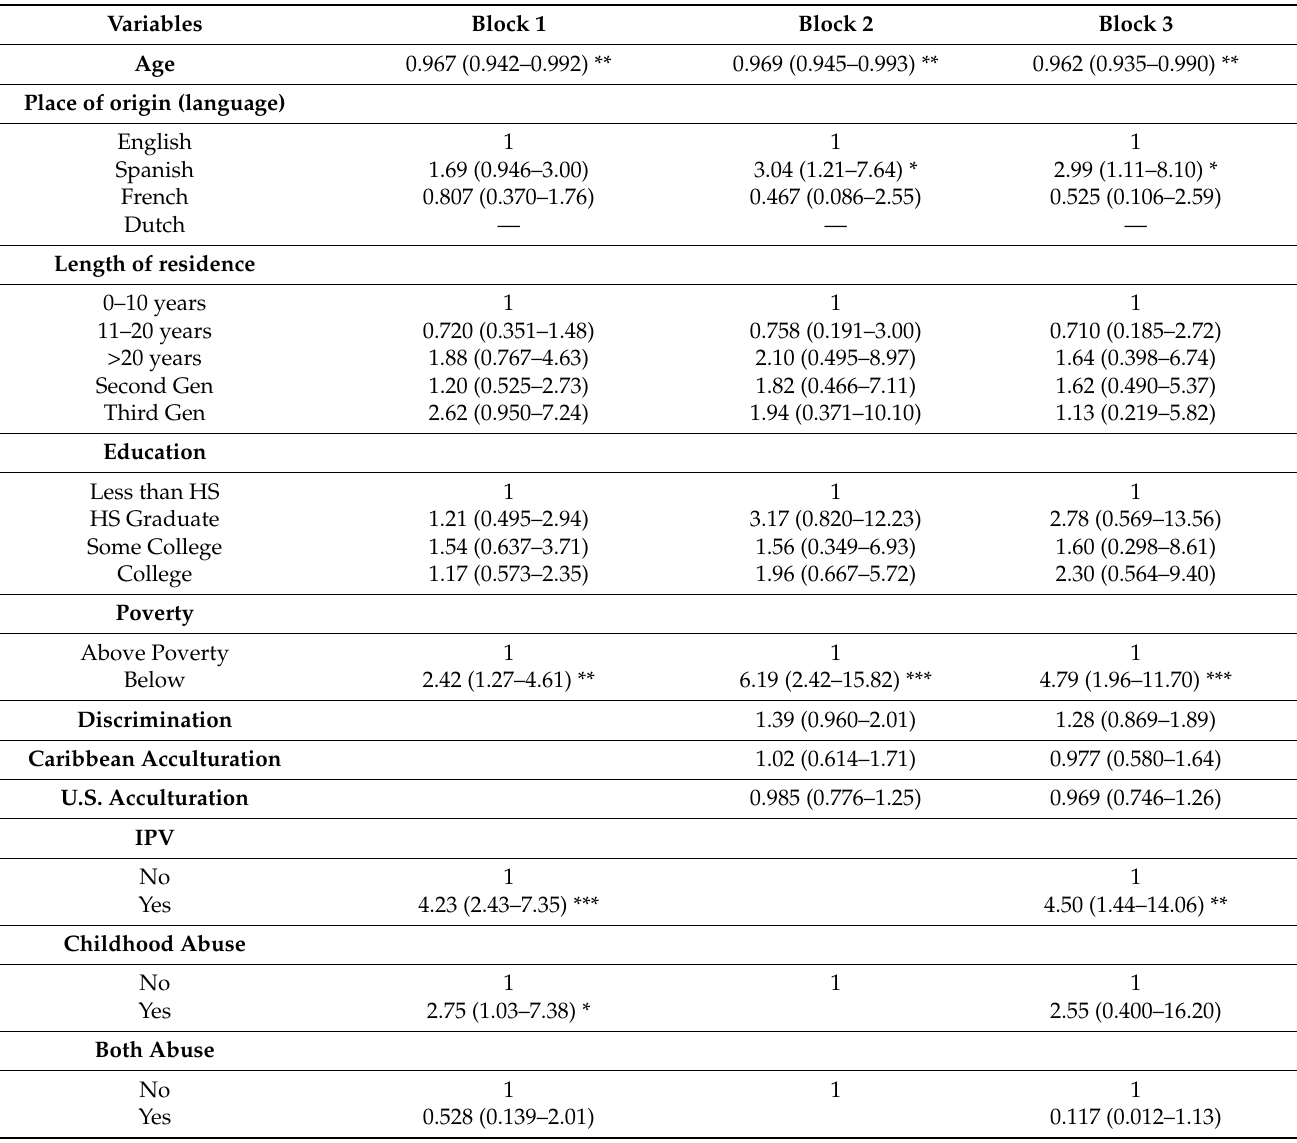
Table 4. Multivariate Analysis Examining Impact of Domestic Violence, Acculturation, Discrimination and Demographic Factors on Lifetime Anxiety